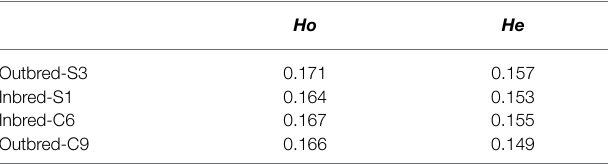
TABLE 1 | Observed (Ho) and expected (He) heterozygosity of the crossbred female Nile tilapia.